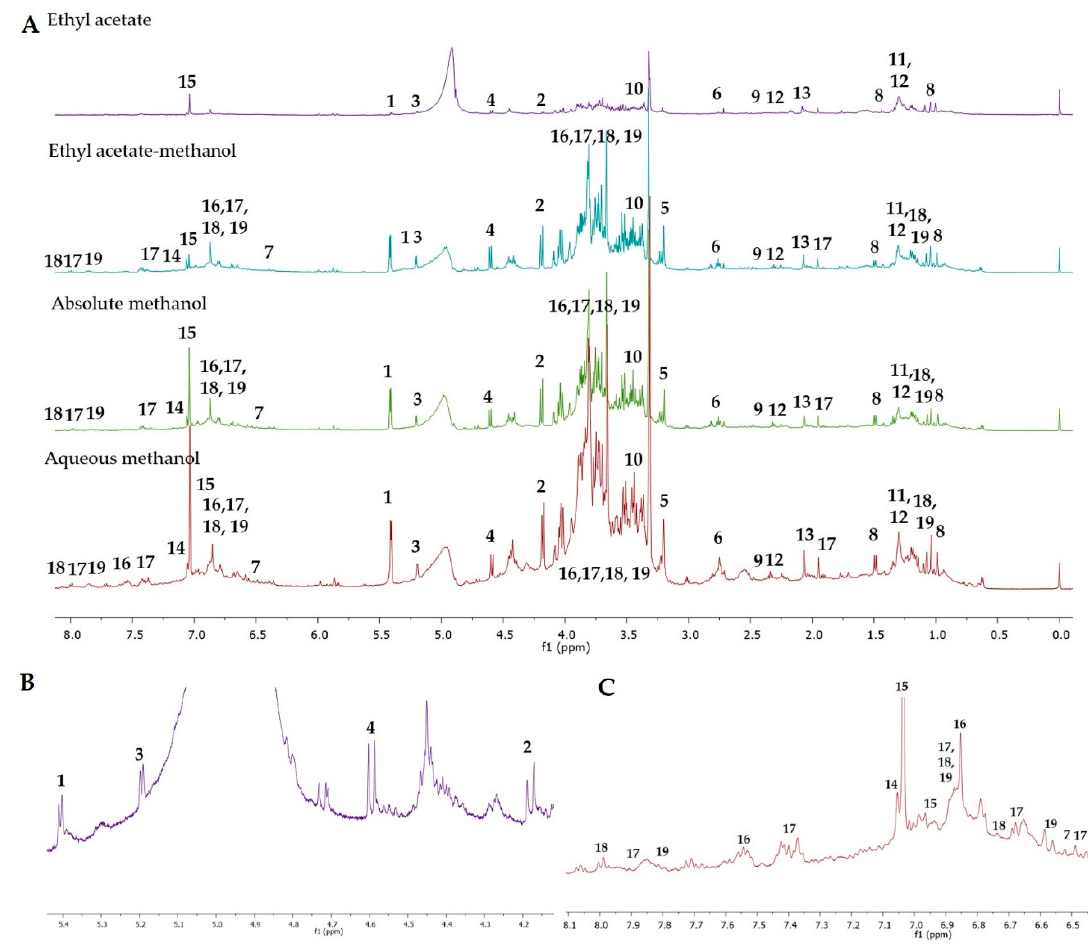
Figure 1. ( A ) Representative proton nuclear magnetic resonance ( 1 H-NMR) spectra (500 MHz, methanol- d 4 ) of different solvent extracts of oil palm leaflet (OPL). ( B ) Part of 1 H-NMR spectra of ethyl acetate extract within range of 4.2 to 5.4 ppm. ( C ) Part of 1 H-NMR spectra of aqueous methanolic extract within range of 6.5 to 8.1 ppm. Identified metabolites: 1 , sucrose; 2 , fructose; 3 , α -glucose; 4 , β -glucose; 5 , choline; 6 , citric acid; 7 , fumaric acid; 8 , palmitic acid; 9 , succinic acid; 10 , aconitic acid; 11 , fatty acid; 12 , α -linolenic acid; 13 , acetic acid; 14 , ( − )-epicatechin; 15 , ( + )-catechin; 16 , orientin; 17 , isoorientin; 18 , vitexin; 19 , isovitexin.